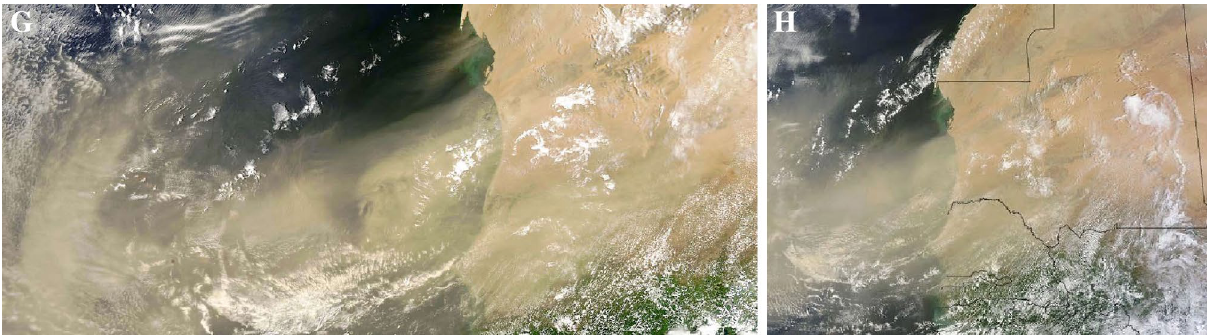
Fig. 4 True-color image of dust ( g ) and image enhancement ( h ) 2012 June 21